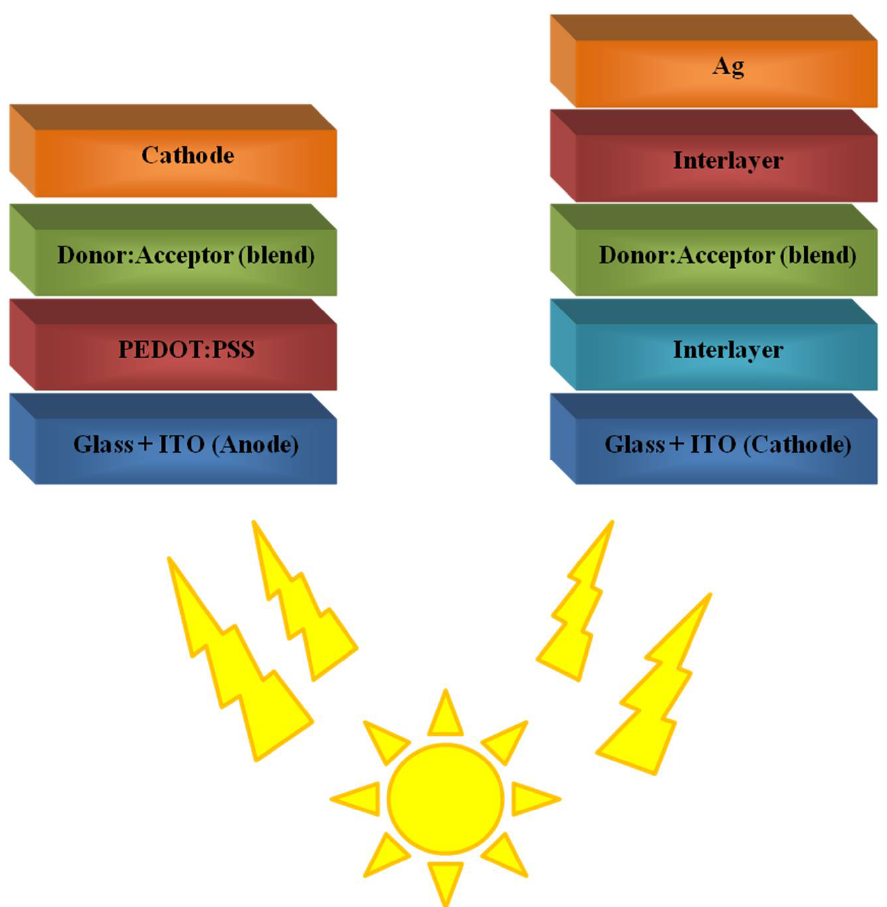
Figure 2. Schematic structure of a BHJ OSC with the conventional and inverted systems.